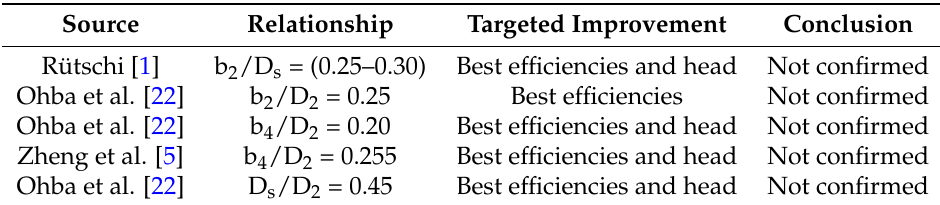
Table 2. Recommended ratios for geometric parameters in